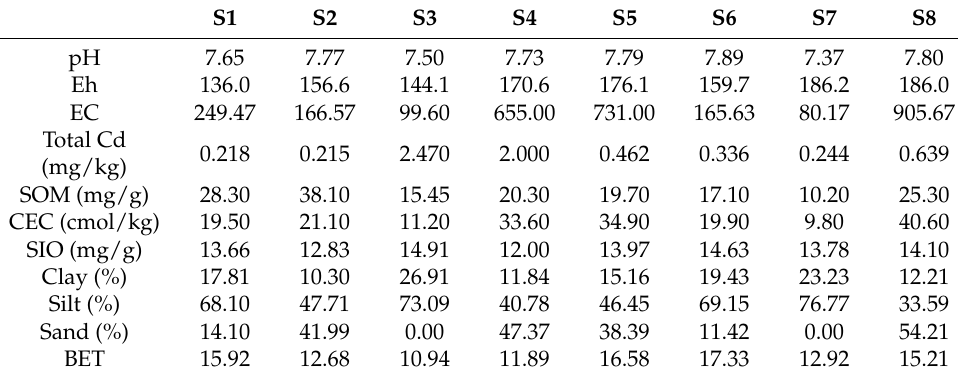
Table 1. Physical and chemical properties of the soil